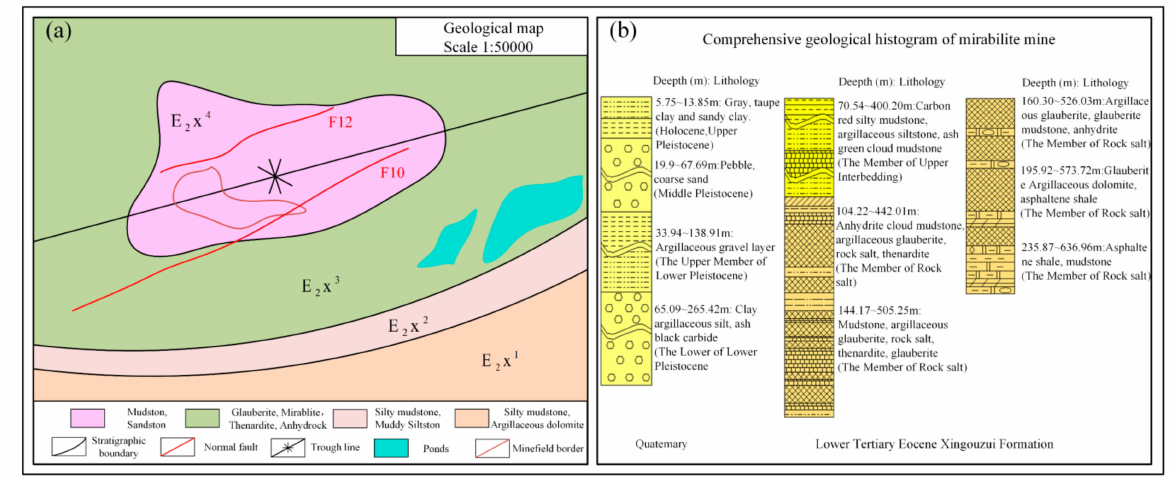
Figure 9. Schematic diagram of the lithological distribution over the study